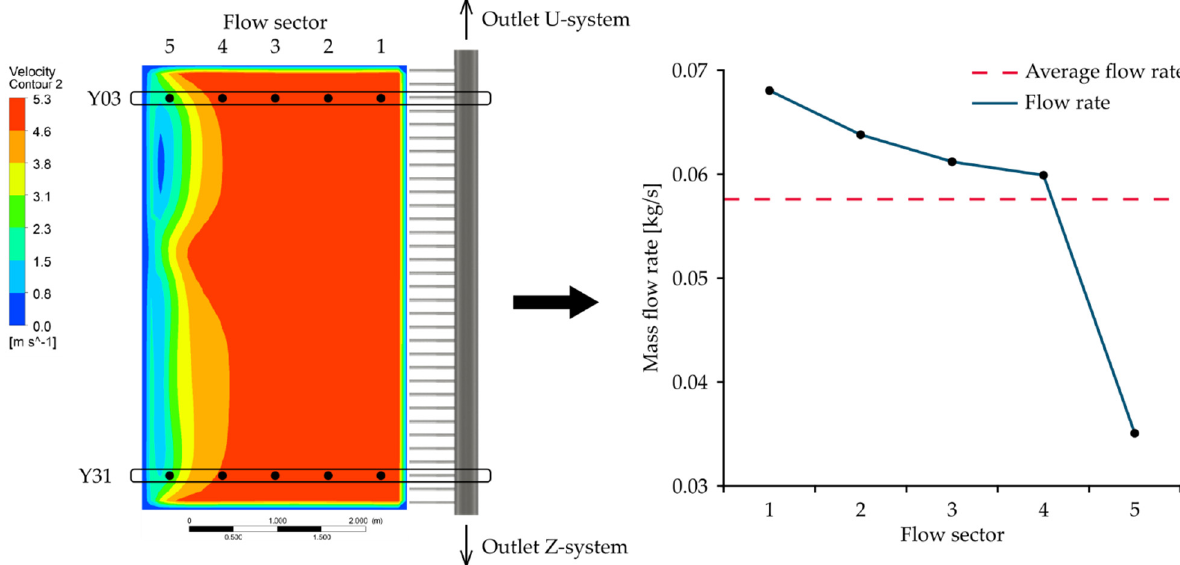
Figure 19. Flue gas flow distribution. Left: velocity field just above the tube bundle obtained via earlier CFD simulations [54]; right: discretized flow rates together with the average flow rate in the respective parts of the shell.